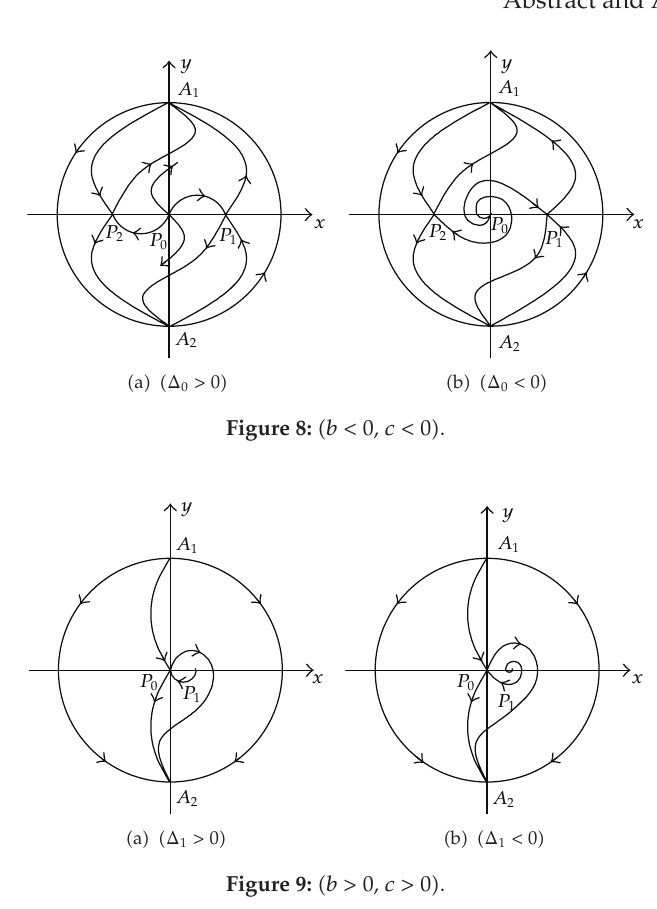
Figure 9: (cid:6) b > 0, c > 0 (cid:7)